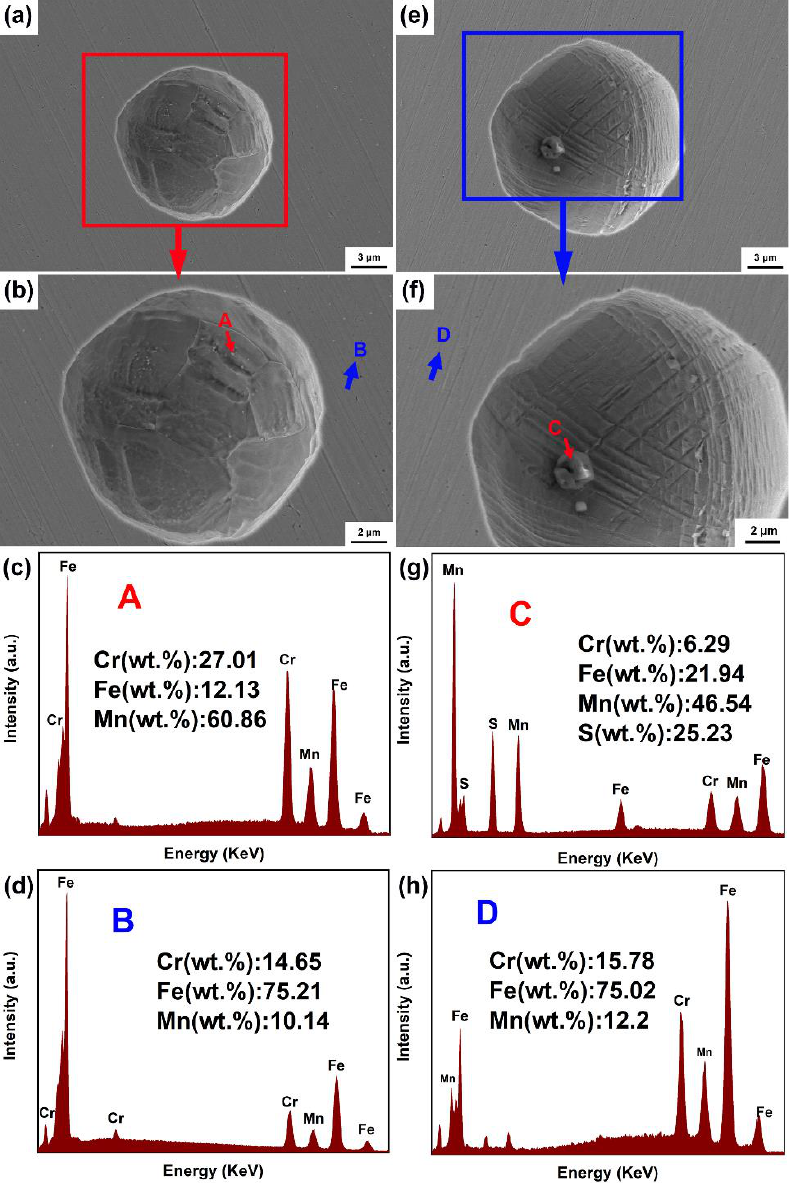
Figure 9. Detailed analysis of the pits in the experimental MASS after immersion test via SEM and EDS: ( a , e ) are the micrograph of one typical pit in CR-MASS and HR-MASS, respectively; ( b , f ) show the magnified image of the area marked by red frame in ( a ) and blue frame in ( e ); ( c , d ) separately show the EDS results of steel substrate (point B in ( b )) and M 23 C 6 carbides (point A in ( b )); ( g , h ) respectively, display the chemical composition of MnS (point C in ( f )) and steel substrate (point D in ( f )).